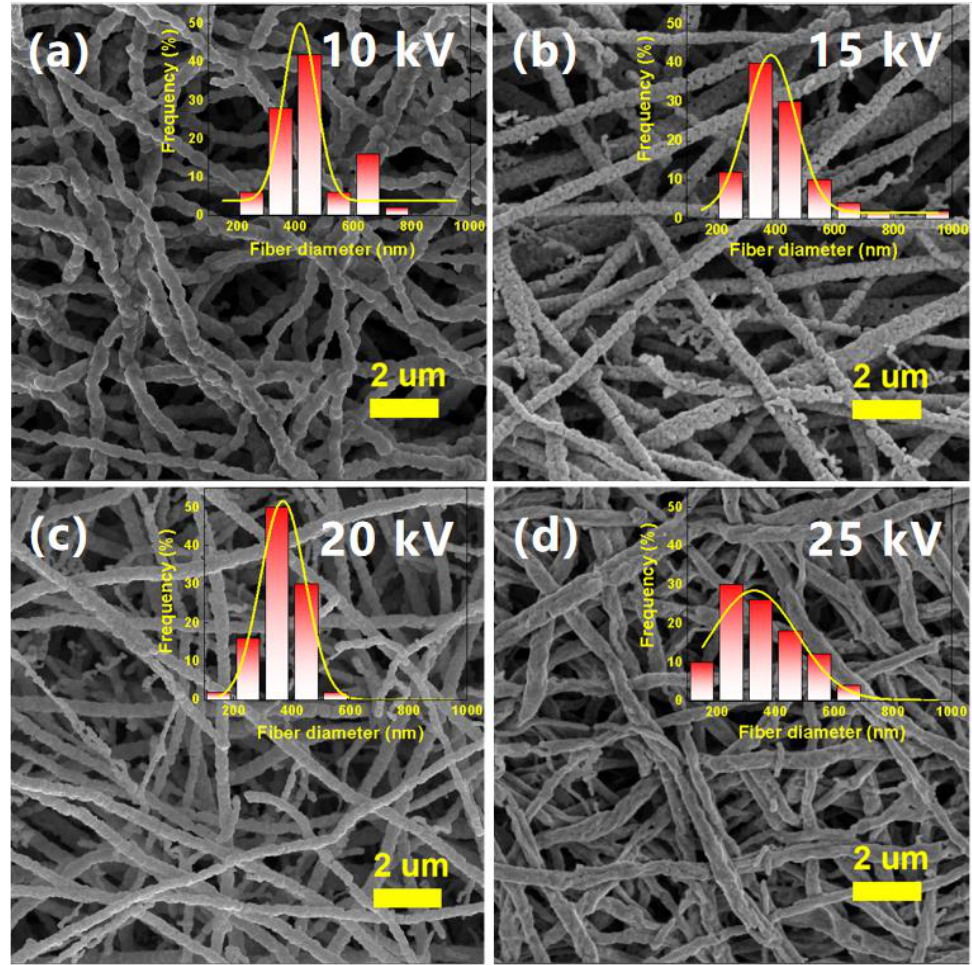
Figure 1. SEM images of NBT nanofibers obtained under different applied voltages at the solution flow rate of 1.0 mL/h and collector’s rotation speed of 1500 rpm: ( a ) 10 kV; ( b ) 15 kV; ( c ) 20 kV; ( d ) 25 kV. The inserted figures are the diameter distributions of NBT nanofibers. Table 1. NBT nanofibers diameters under different parameters and the relative contribution of each